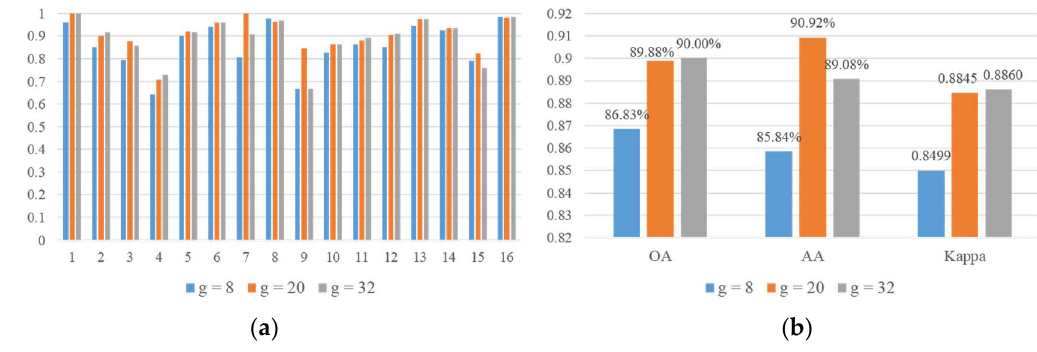
Figure 12. Classification result of proposed method when nc_layer = 2, g = 8/20/32: ( a ) shows the classification accuracy per class; ( b ) shows overall accuracy/average accuracy/kappa coefficient (OA/AA/Kappa).